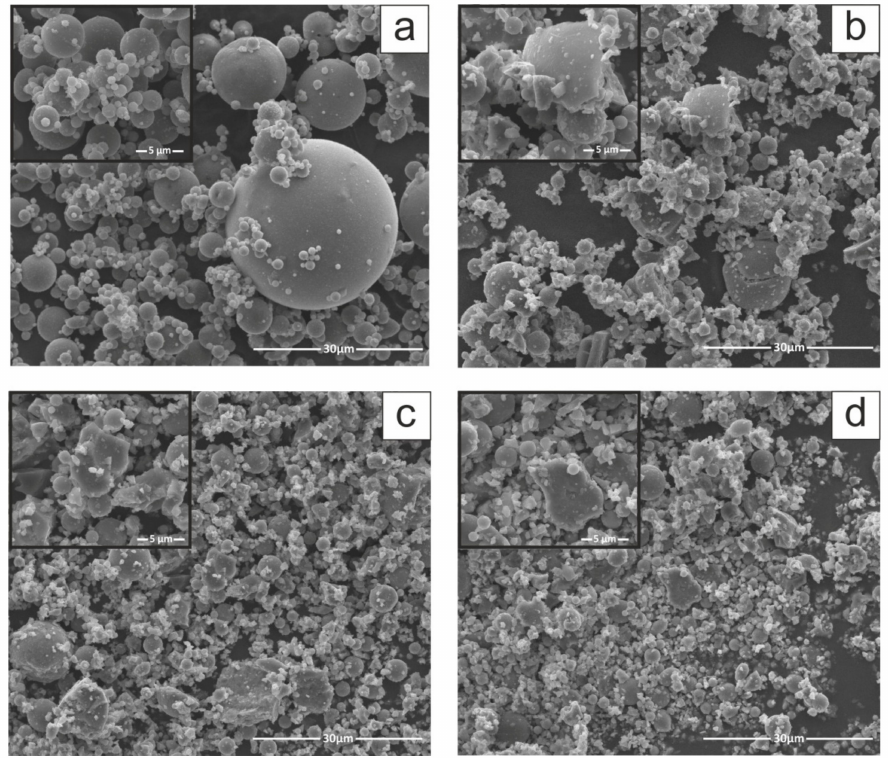
Figure 3. SEM micrographs of fly ash morphology ( a ) FA0 (raw), ( b ) FA1 (1 h of milling), ( c ) FA2 (2 h of milling) and ( d ) FA3 (3 h of milling) (magnification 4000, inset